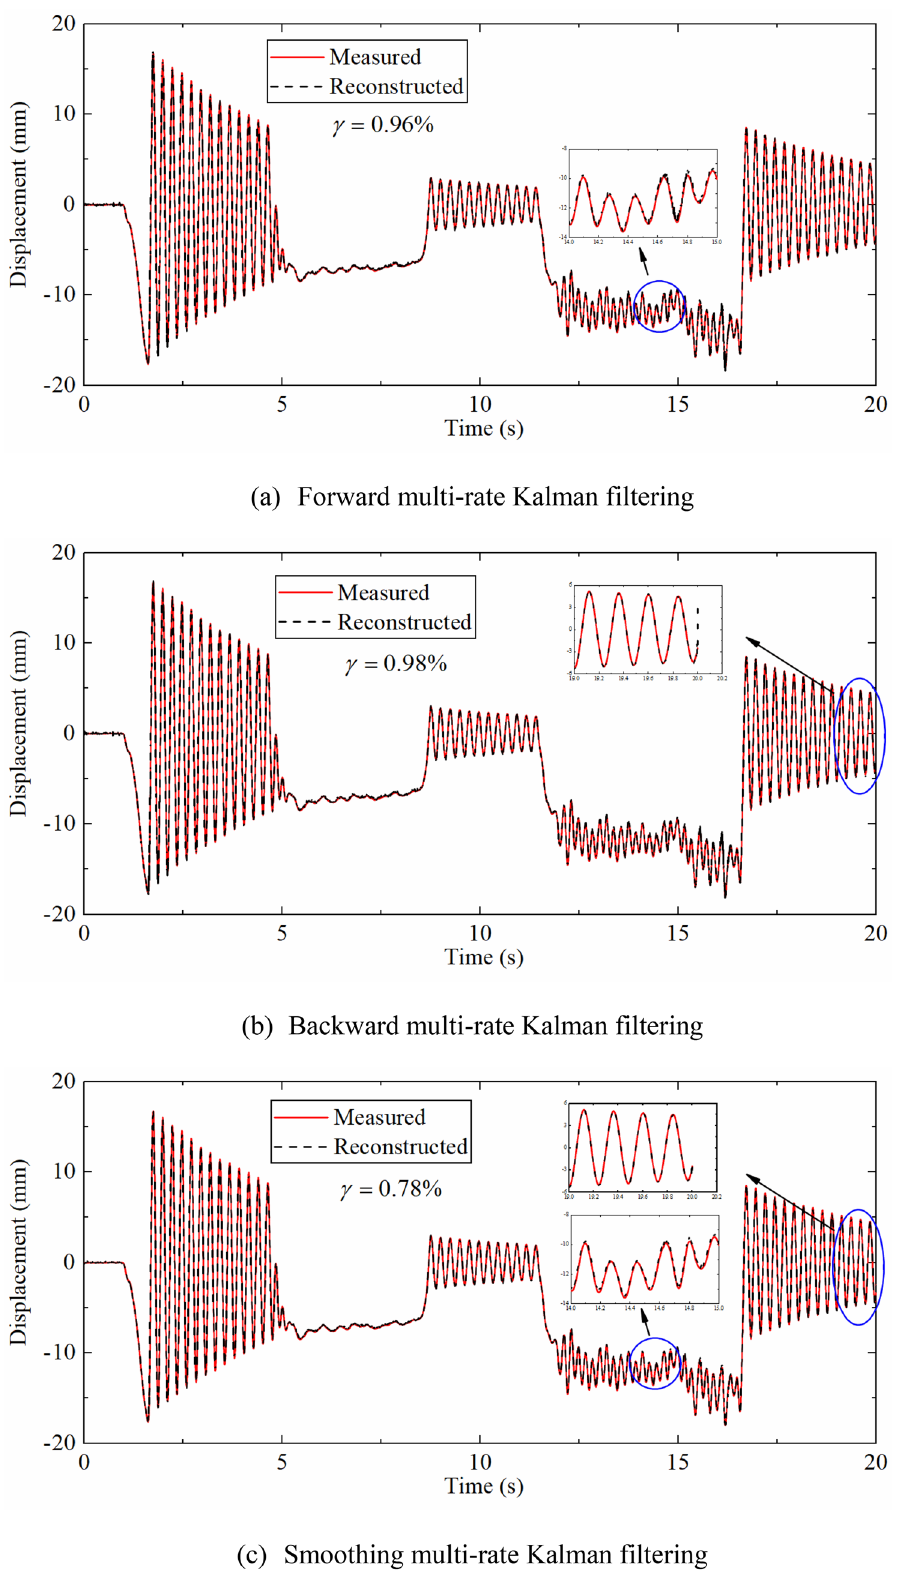
Figure 14. Comparison between displacement reconstructed by different Kalman filtering algorithms and measured